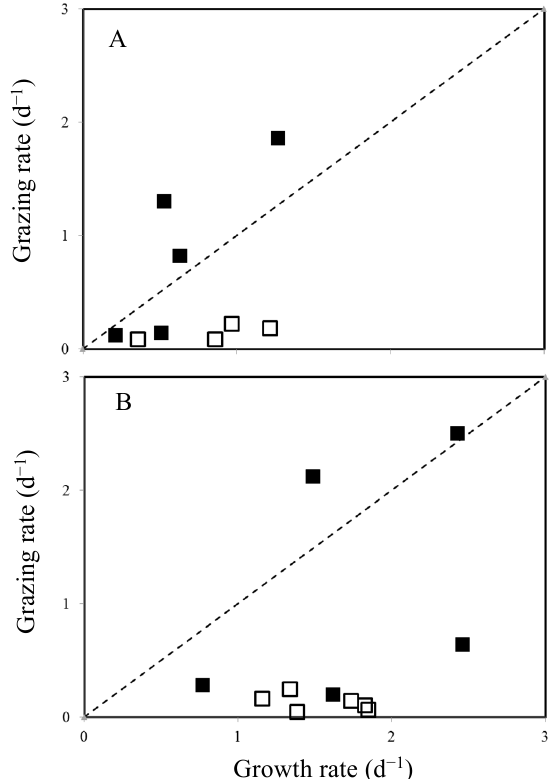
Figure 7. Comparison between the Synechococcus spp. ( A ) and picoeukaryotic growth rates ( B ) and nanoflagellate grazing rate during the study period. Dotted lines represent a 1:1 ratio. ( ■ ): cold seasons <25 °C, ( □ ): warm seasons >25 °C.